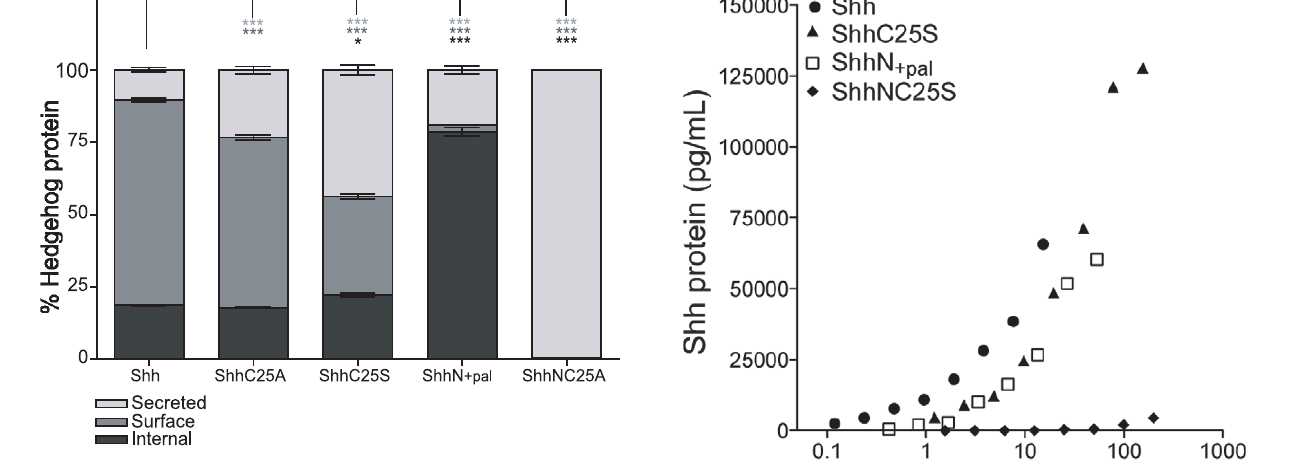
fected cells, the total amount of protein measured in the lysate by ELISA was divided by the number of transfected cells (EGFP + ) for that well.